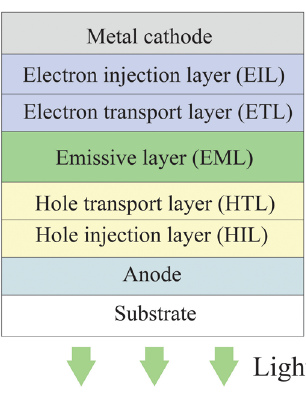
Figure 4: Device structure of a typical OLED with NPs - doped